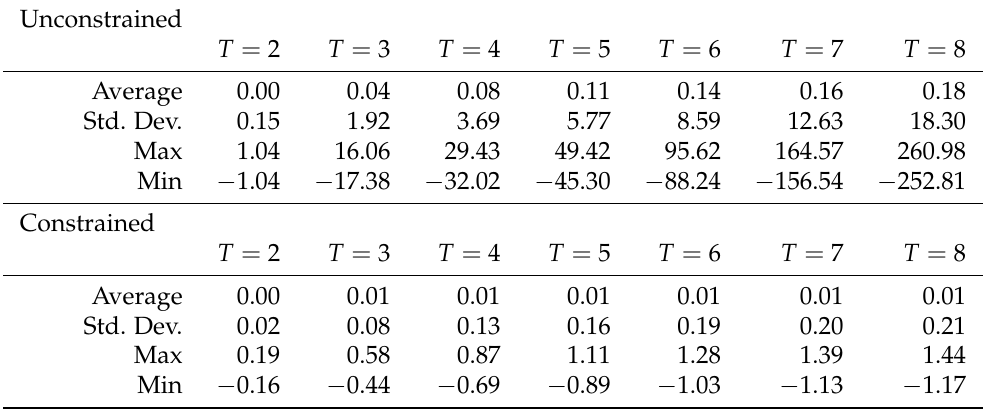
Table 2. Implied volatility estimation errors by time to maturity T